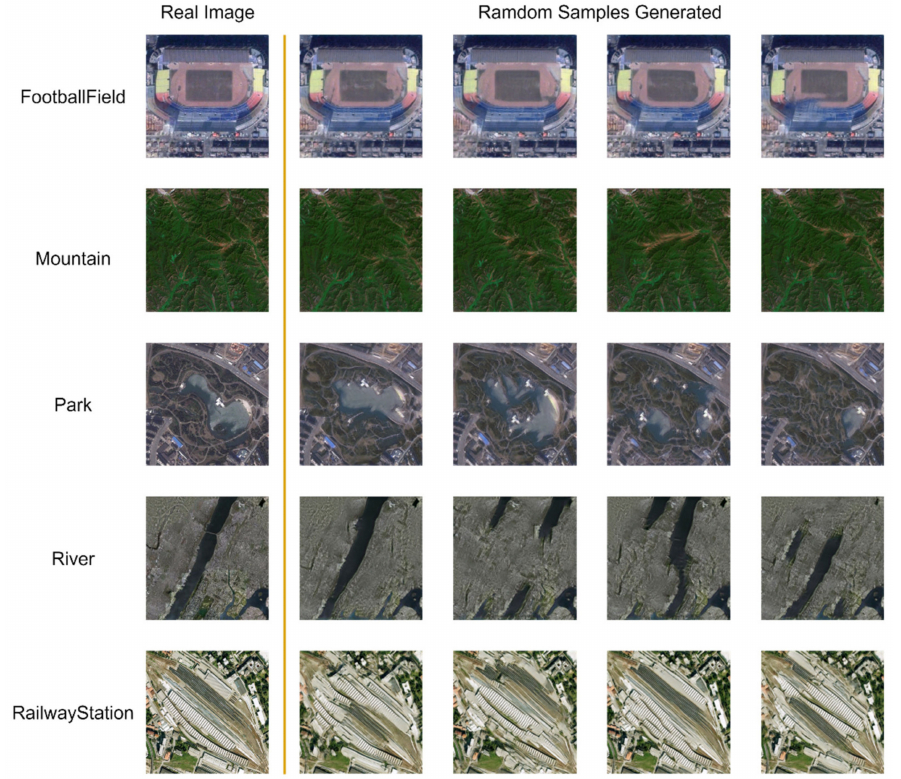
Figure 9. Random remote sensing image fake samples by the original SinGAN.